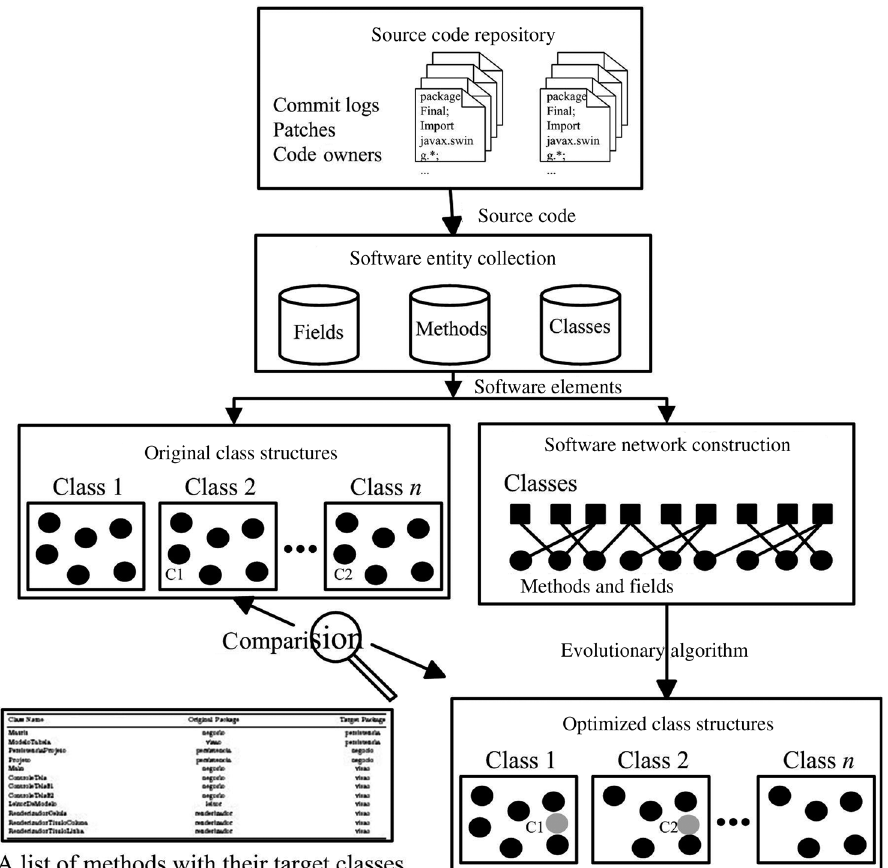
Figure 1. The Workflow of the Proposed CLEAR